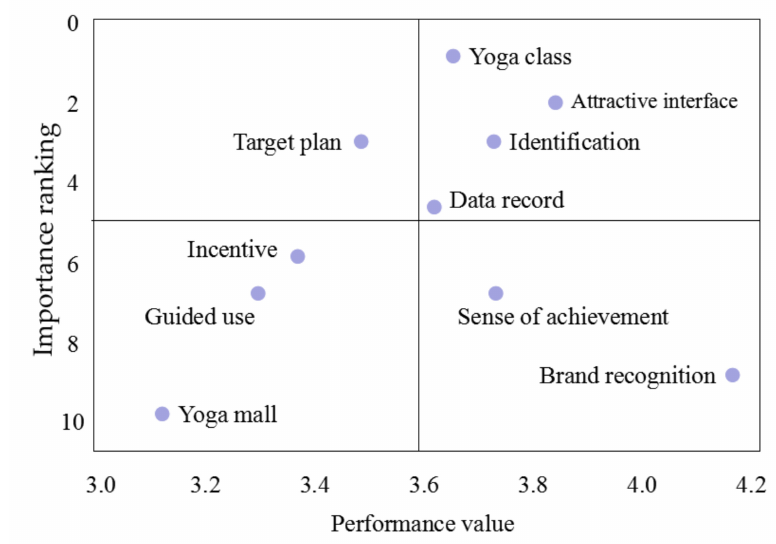
Figure 3. Importance–Performance Analysis (IPA) of the Daily Yoga